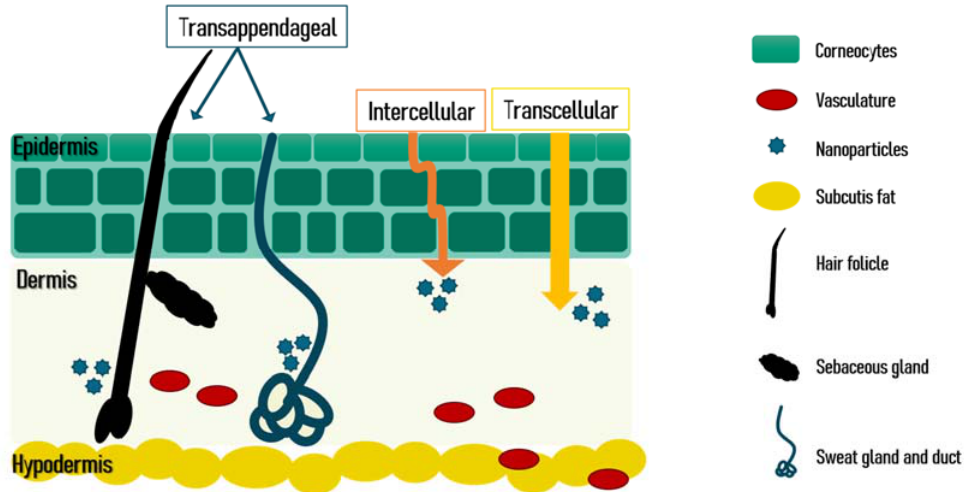
Figure 9. Schematic view of the skin layers and skin penetration routes. Reprinted from [139] under a CC BY license.